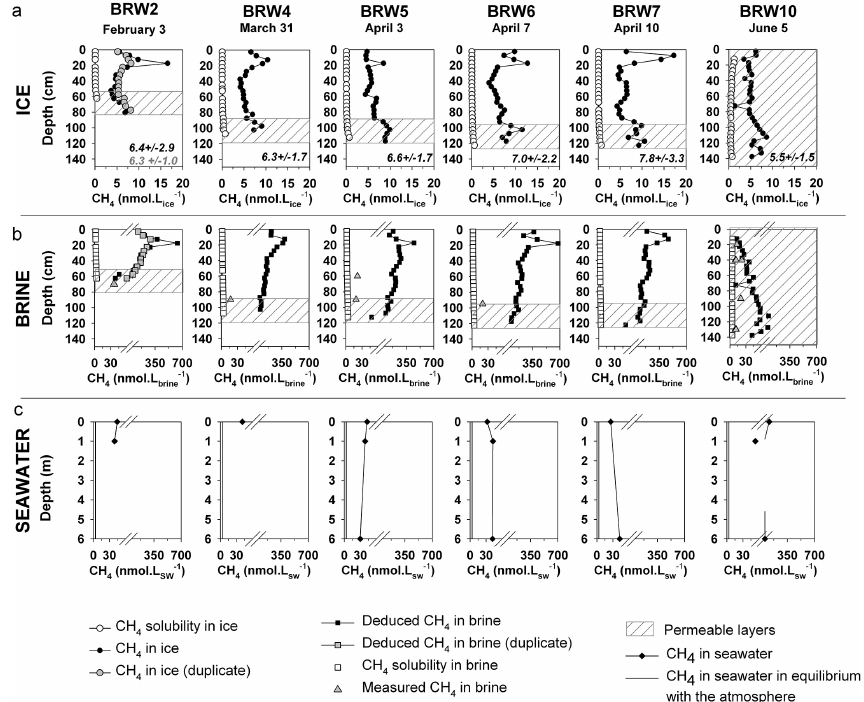
Figure 3. Evolution of CH 4 concentration in (a) bulk ice, (b) brine and (c) seawater (black dots, squares and diamonds respectively), compared to CH 4 solubility in ice, brine and seawater that is in equilibrium with the atmosphere (white dots, white squares and black straight lines respectively). Grey dots and grey squares are measurements made on duplicate samples of BRW2. Grey triangles in (b) are CH 4 measurements in brine sackholes. The break in the x axes of (b) and (c) is set at 60nmolL. Dashed areas are permeable layers (i.e. layers with a brine volume fraction above